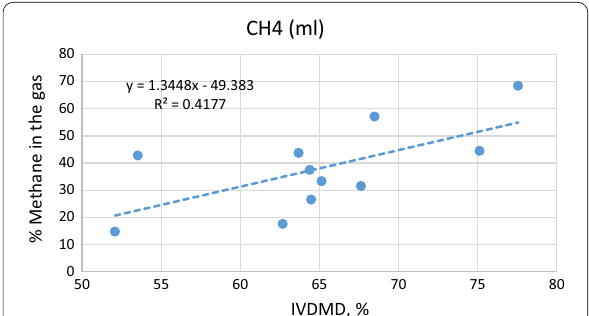
Fig. 1 Relationship between in vitro digestibility and the percentage of methane in the gas